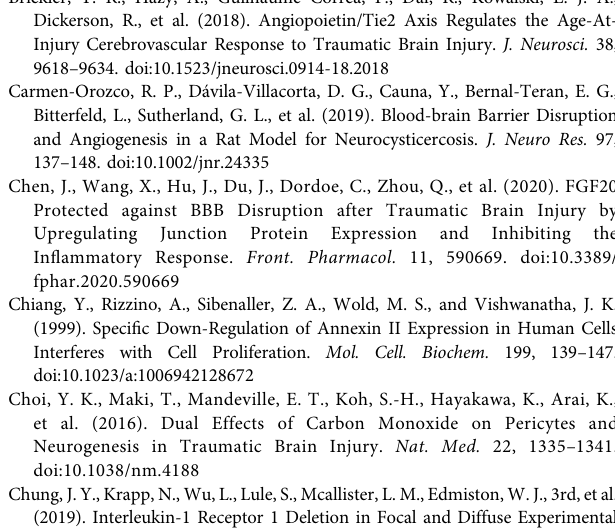
Supplementary Figure 1 | Plasma concentration of Annexin A2. The plasma concentrations of Annexin A2 were quanti fi ed at 0, 2, 6, 12, 24, 48, and 72 h post- injection (i.p.) by performing ELISA by using speci fi c calibration curves. The concentrations are expressed as micrograms of Annexin A2 per milligram of the plasma and are represented as means and SEM. n (cid:1) 3 mice per time point. Supplementary Figure 2 | rA2 administration increases protein levels of BDNF in the ipsilateral hemisphere after TBI. Representative gel images and quanti fi cation of western blotting for BDNF in ipsilatral brain of mice treated with rA2 (1 mg/kg) or vehicle (BSA, 1 mg/kg) at 3 and 7 days after TBI. n (cid:1) 5 mice per group. Data are expressed as mean ± SEM, * p < 0.05 compared to Sham, # p < 0.05 compared to BSA. Supplementary Figure 3 | rA2 exposure promotes angiogenic capability of HBMEC in vitro. The effects of rA2 exposure at 2 µg/ml for 24 h in the number of tube formation, and enhanced endothelial migration in cultured HBMEC. (A) Representative images of tube formation and quanti fi cation of tube numbers in the cultured HBMEC. Data are expressed as mean ± SEM, n (cid:1) 6 wells per group, * p < 0.05 compared with PBS under normal condition, # p < 0.05 compared with rA2 under normal condition. (B) Representative images of scratch migration assay and quanti fi cation of gape closure (%) in HBMEC. Data are expressed as mean ± SEM, n (cid:1) 5 wells per group, * p < 0.05 compared with PBS treated